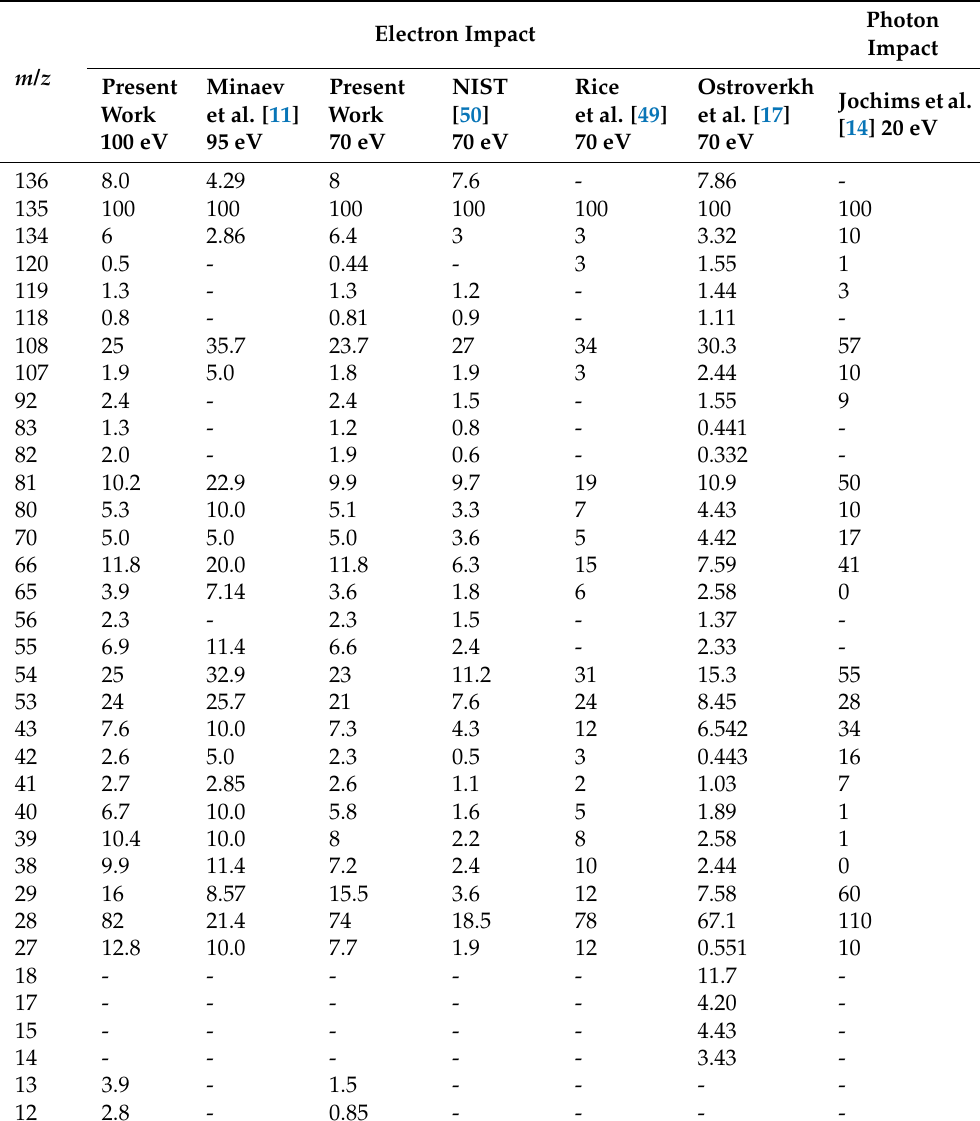
Table 1. Relative intensities of major fragment ions from